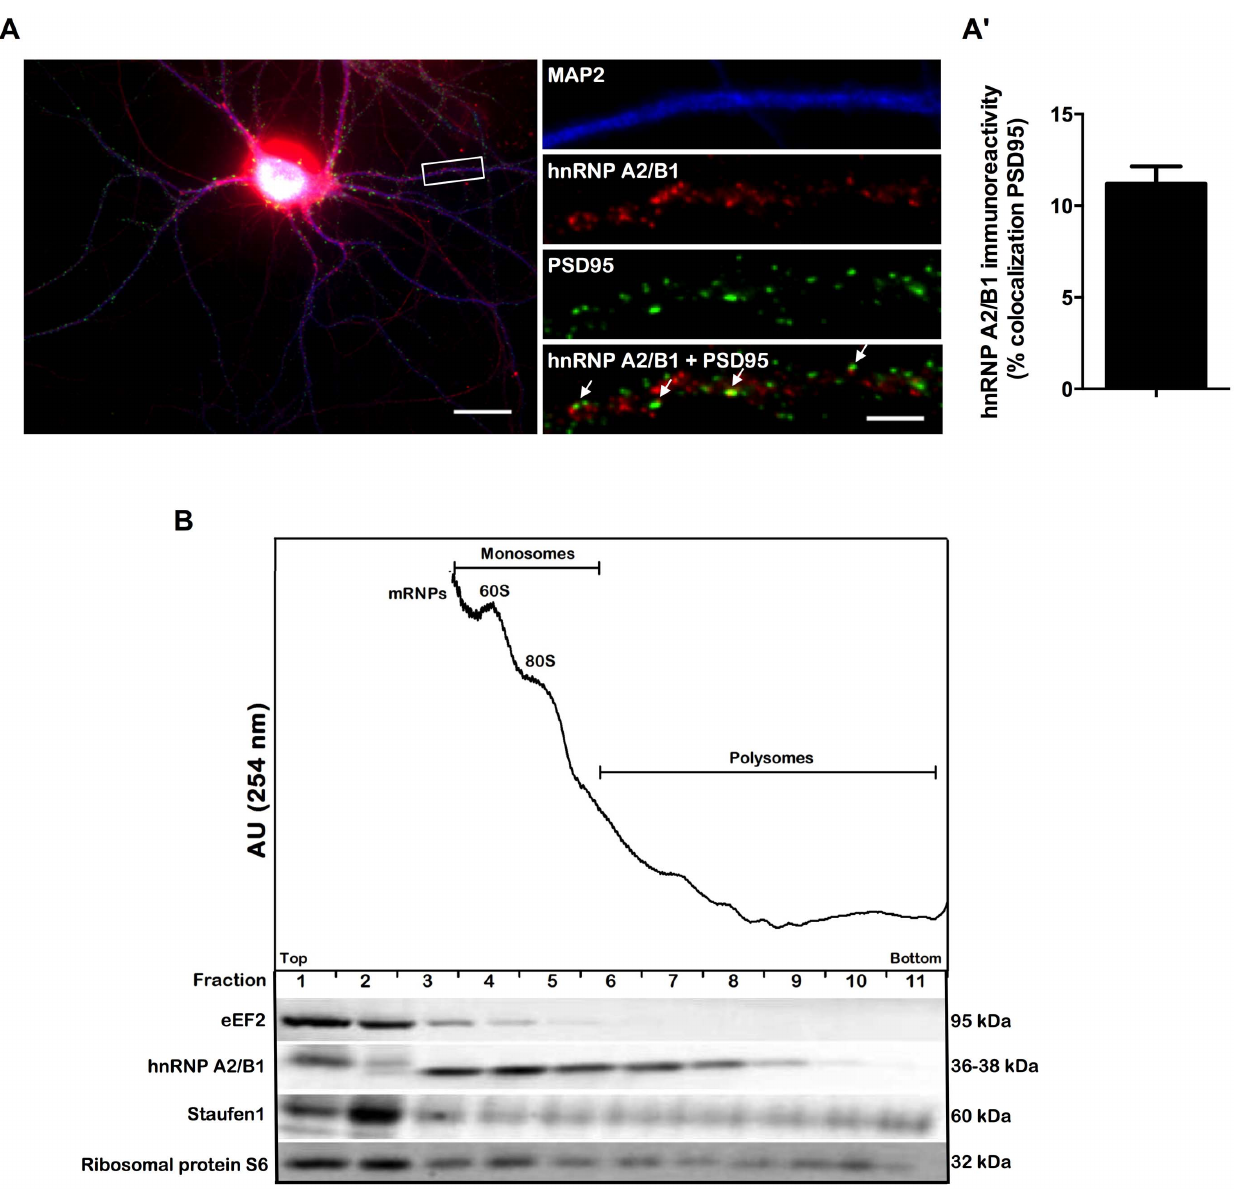
Figure 1. hnRNP A2/B1 is present in synaptic polyribosomal fractions and colocalizes with PSD95 in dendrites of hippocampal neurons. (A) Cultured hippocampal neurons immunostained for MAP2 (blue), hnRNP A2/B1 (red) and PSD95 (green) show that hnRNP A2/B1 is present in synaptic sites as indicated by the colocalization with the postsynaptic marker PSD95 (white arrows). Scale bars=25 m m and 4 m m for low and high magnification images, respectively. The images are representative of six different experiments performed in independent preparations, with a total of 71 cells analysed. (A 9 ) The percentage of dendritic hnRNP A2/B1 signal that colocalizes with PSD95 was analysed using ImageJ software (mean 6 SEM.). (B) Co-sedimentation of synaptoneurosomal proteins using a 10–50% linear sucrose gradient. The polyribosomes, monosomes and mRNPs (non-polysomal fractions) were detected by UV absorbance at 254 nm and the gradient was collected in 11 fractions. Equal volumes from each fraction were analysed by SDS-PAGE and Western blot using antibodies that recognize hnRNP A2/B1, Staufen1, eEF2 and ribosomal protein S6. The results are representative of two different experiments performed in independent synaptoneurosomal preparations.